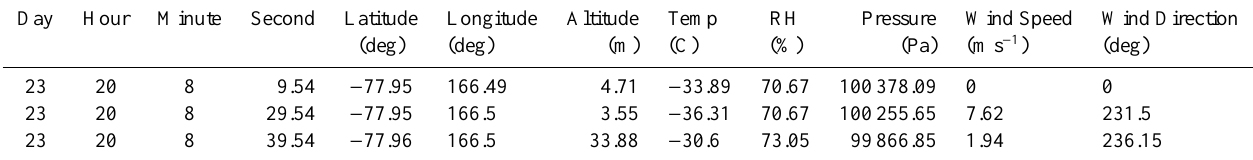
Table 6. A sample of the data available in the USAP-DCC repository. Data have been truncated in this table to save